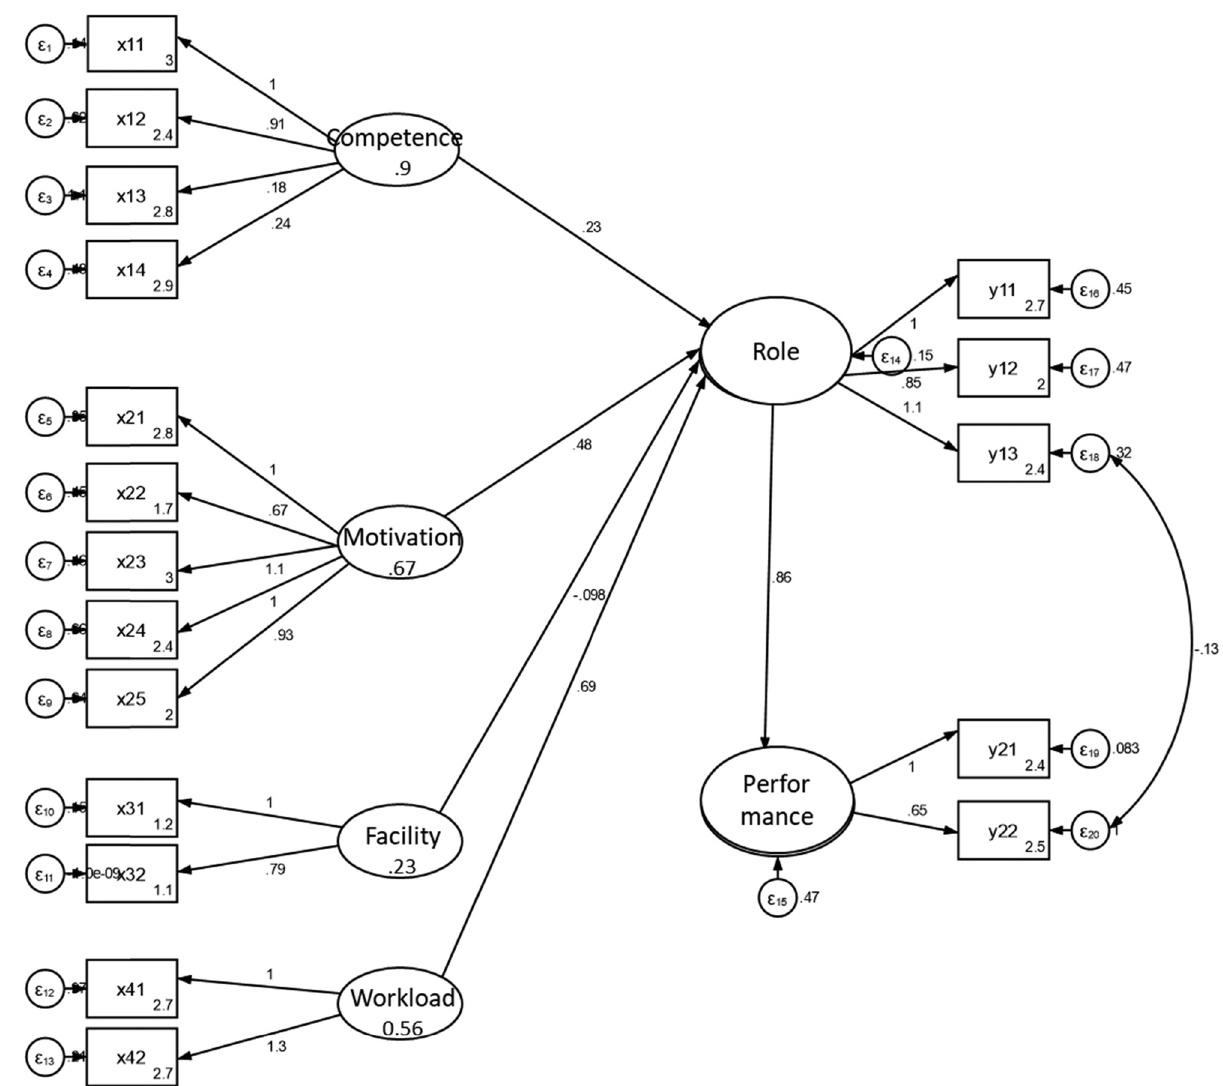
Figure 2: Estimated parameters of model 1.